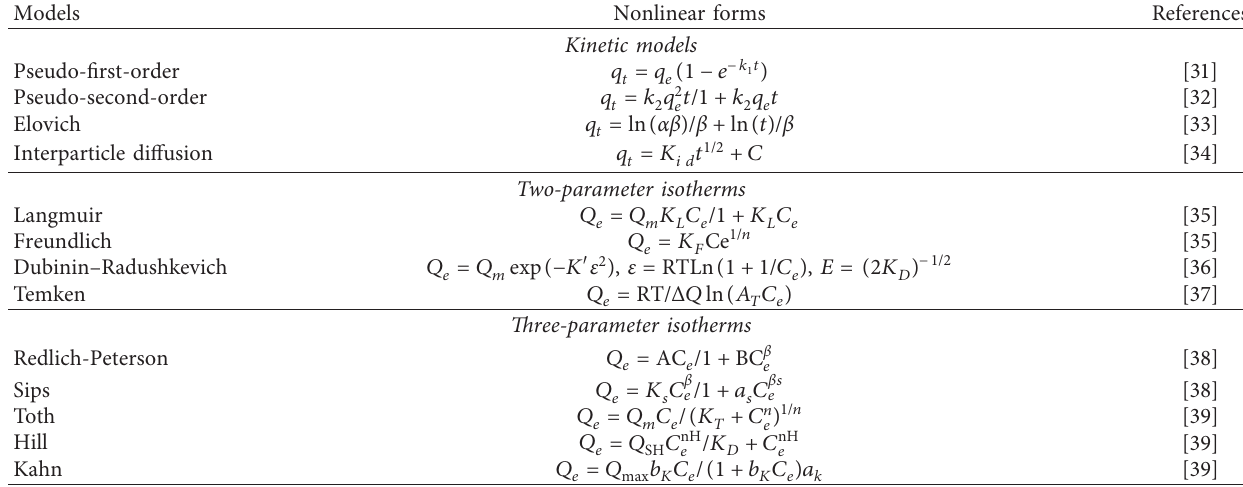
Table 3: Nonlinear forms of kinetic and isotherms models.